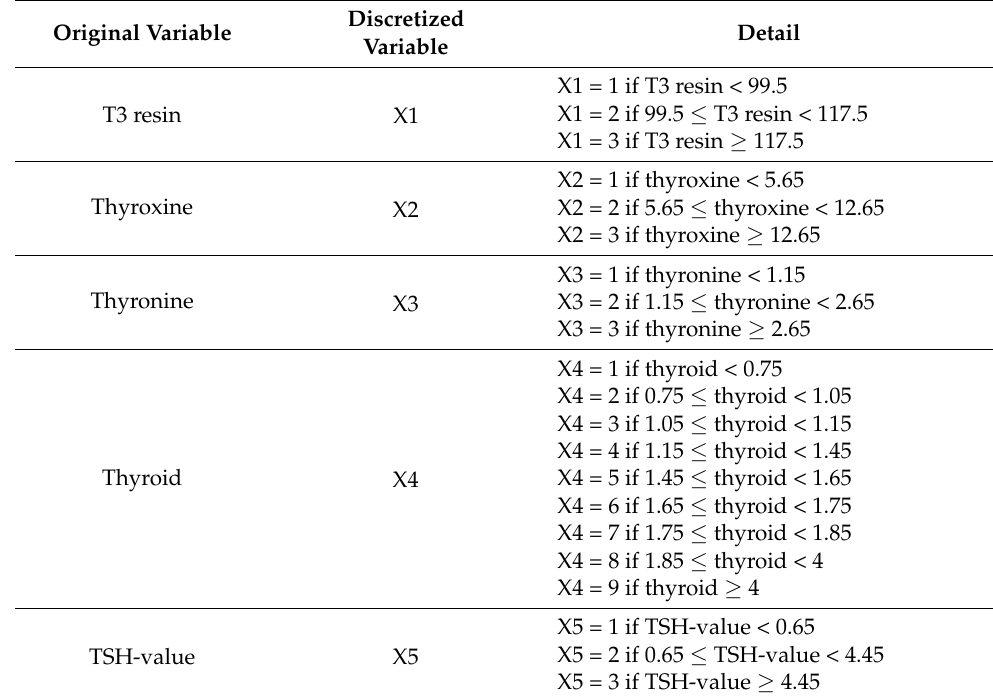
Table 2. Discretized variables generated using the classification tree method: thyroid dataset.